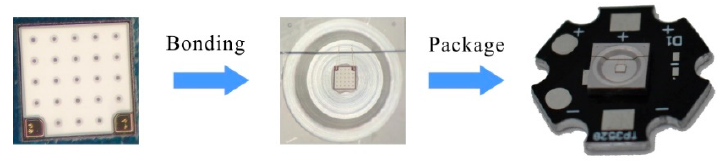
Figure 4. Packaging process of UV-light-emitting diodes (LEDs).